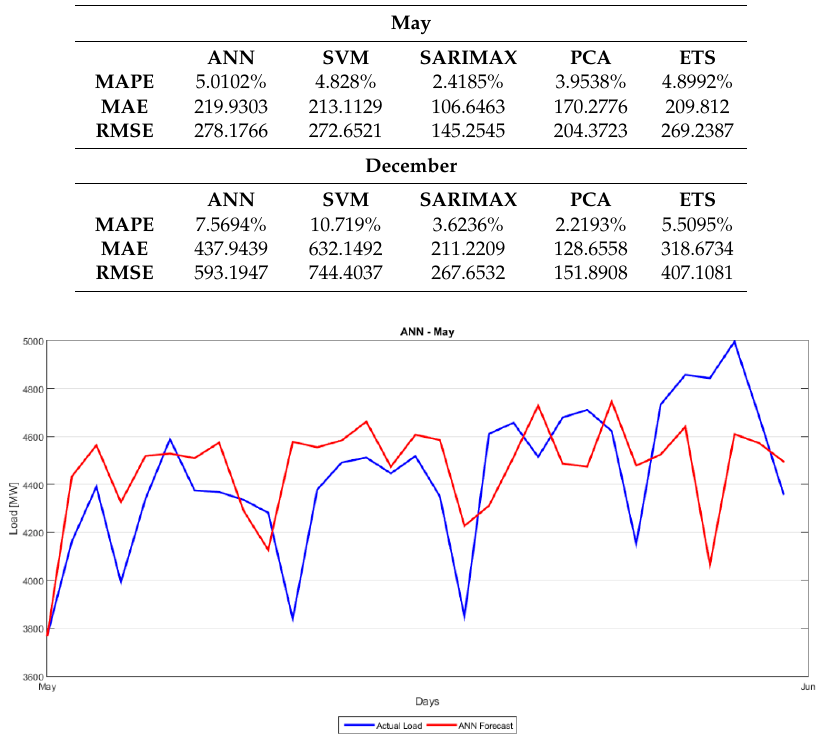
Figure 24. ANN forecast for May 2014. Table 11. Model comparison for May and December 2014.